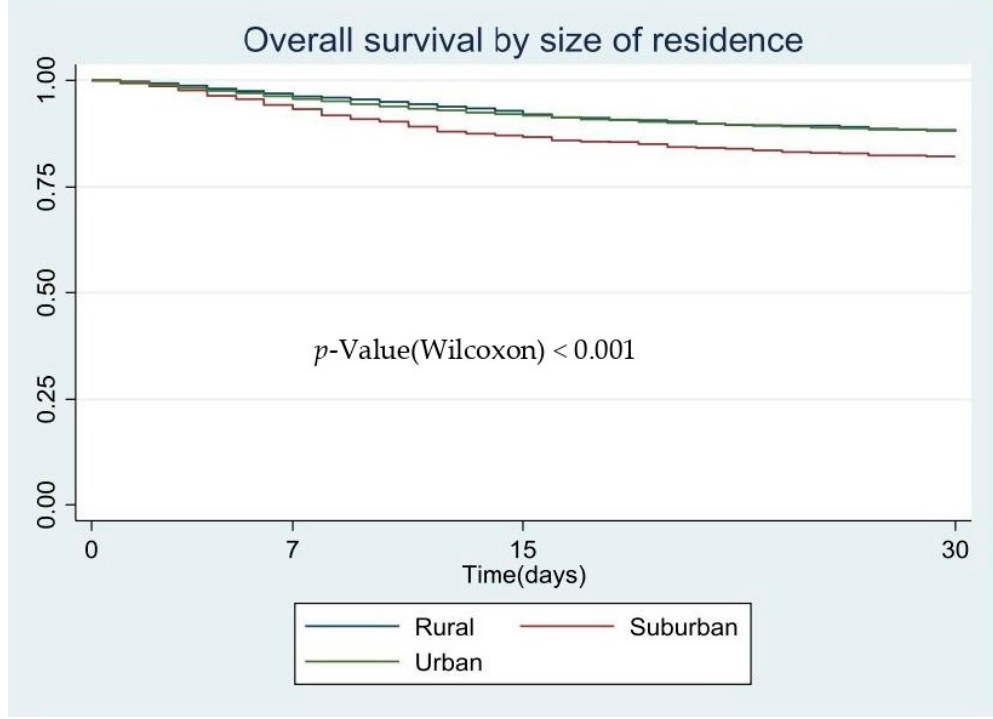
Figure 3. Overall survival by size of residence, Kaplan–Meier survival.